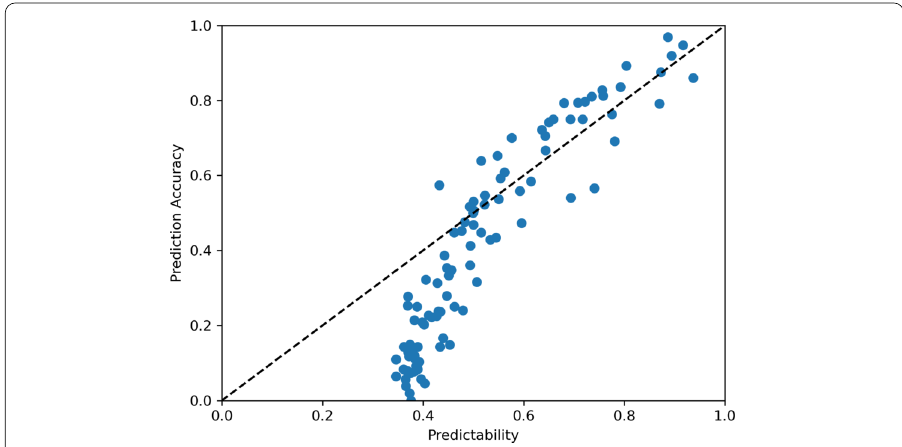
Figure 5 Predictability of sequences in comparison to the accuracy of the best predictor. The black dashed line represents the x = y line, where predictability is equal to the accuracy of